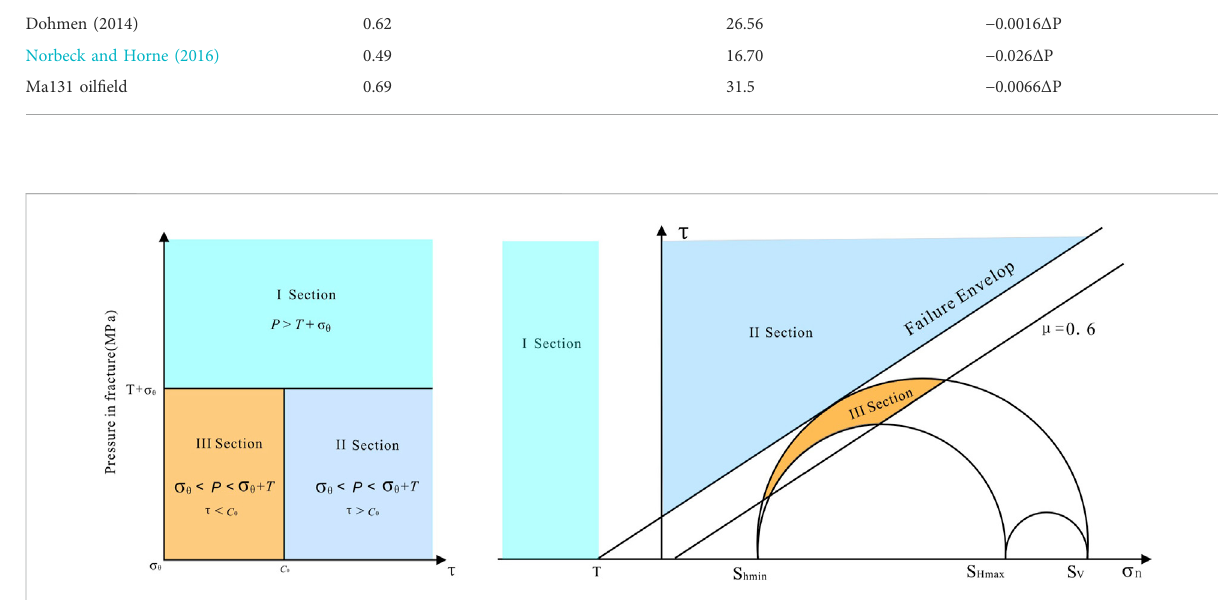
FIGURE 3 The stress mechanism controlling the formation of multiple types of fractures in tight